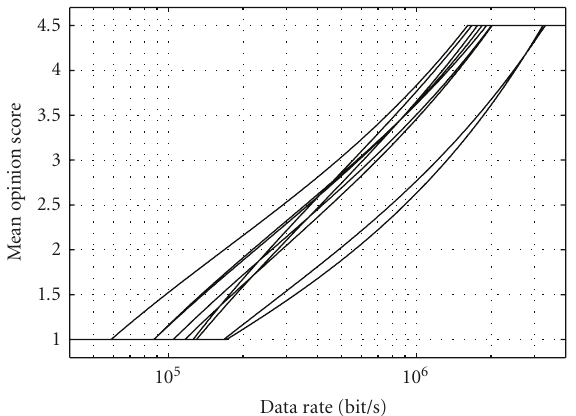
Figure 2: Time variant application characteristic of “Foreman” video